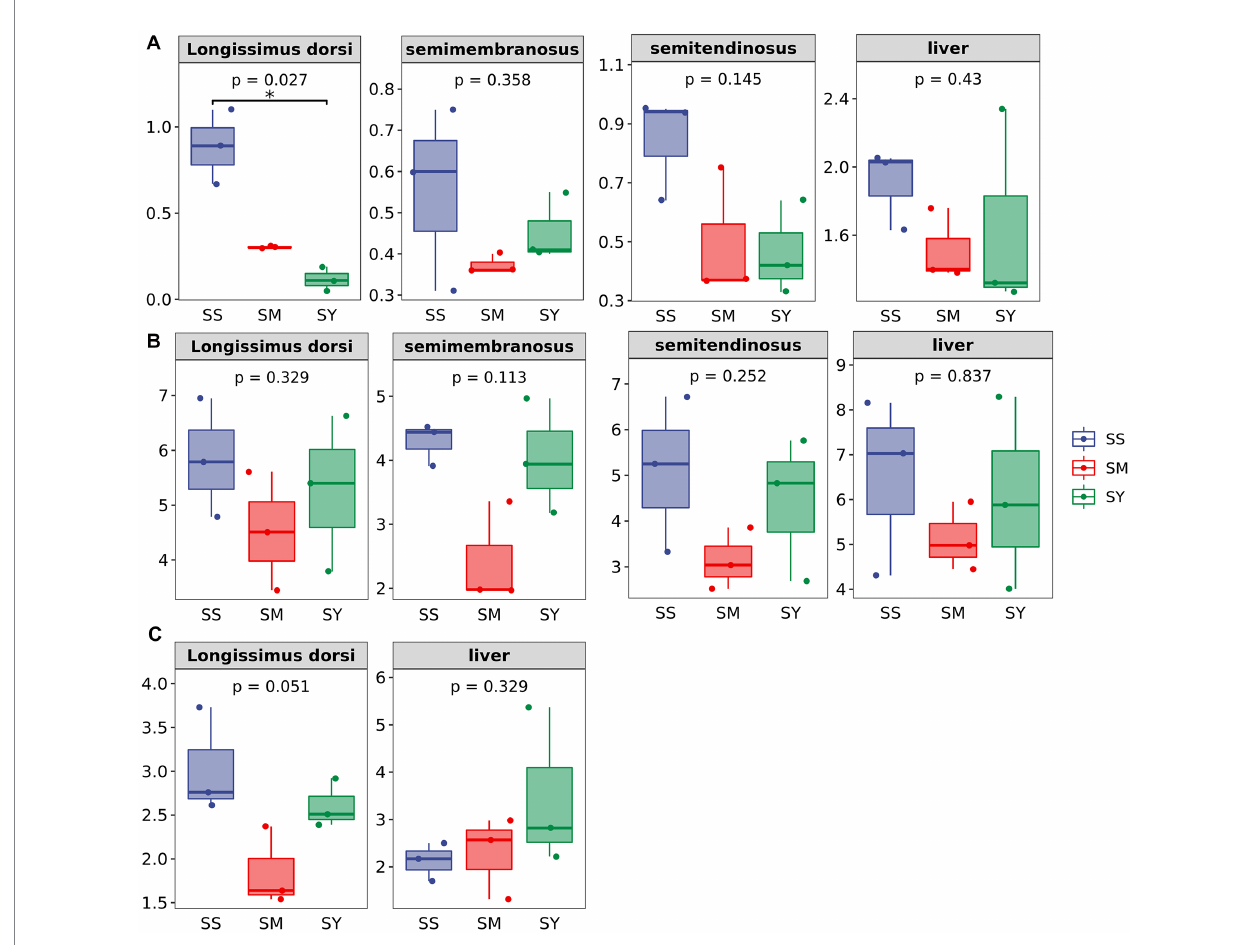
FIGURE 4 Effects of different Se sources on concentrations of MDA and GSH and GSH–Px activities in muscle and liver of beef cattle ( n = 3). (A) malondialdehyde (MDA) concentrations in longissimus dorsi (LD); semimembranosus (SM), and semitendinosus (ST) and Liver; (B) antioxidant enzyme glutathione peroxidase (GSH-PX) activity of LD, SM, ST and Liver; (C) glutathione (GSH) concentrations of LD and Liver. * p < 0.05, ** p <0.01. SS, diet supplemented 0.1 mg Se/kg DM from sodium selenite; SM, diet supplemented 0.1 mg Se/kg DM from selenomethionine; SY = with 0.1 mg Se/kg Se-enriched yeast.